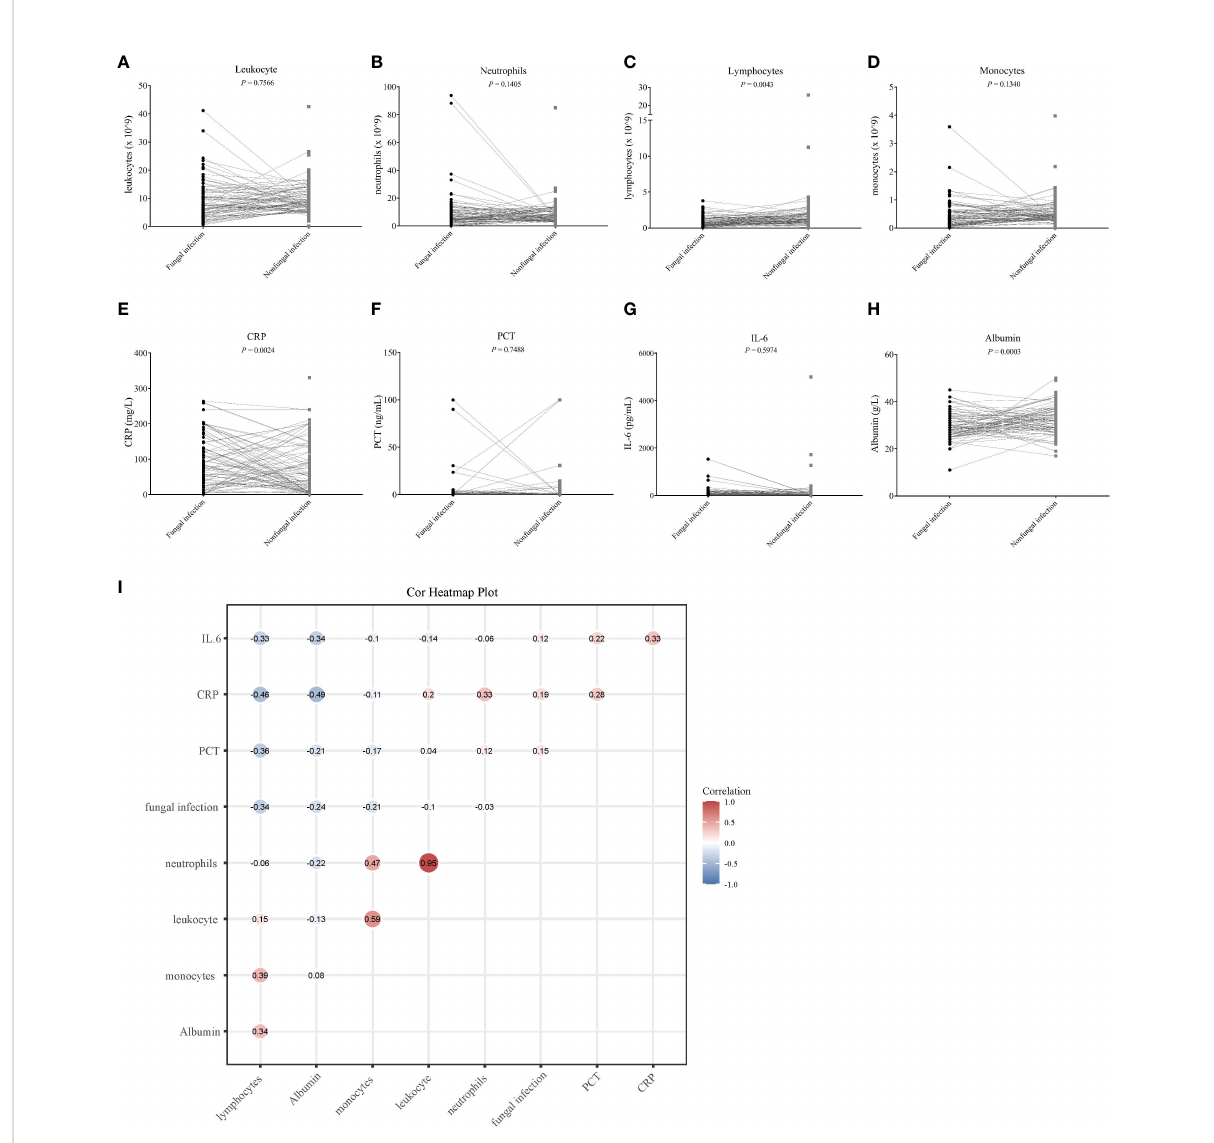
FIGURE 6 The correlation between eight clinical infection indicators and fungal infection. (A – H) Differential analysis of eight clinical infection indices in the fungal and non-fungal infection groups. The Student ’ s t-test was used to evaluate the signi fi cance of any differences detected, and values with a P < 0.05 were considered as signi fi cant. (I) Heat map corresponding to the correlation analysis between the clinical infection indicators and fungal infection; a correlation coef fi cient is shown at each spot of the matrix. The Spearman method was used for the correlation